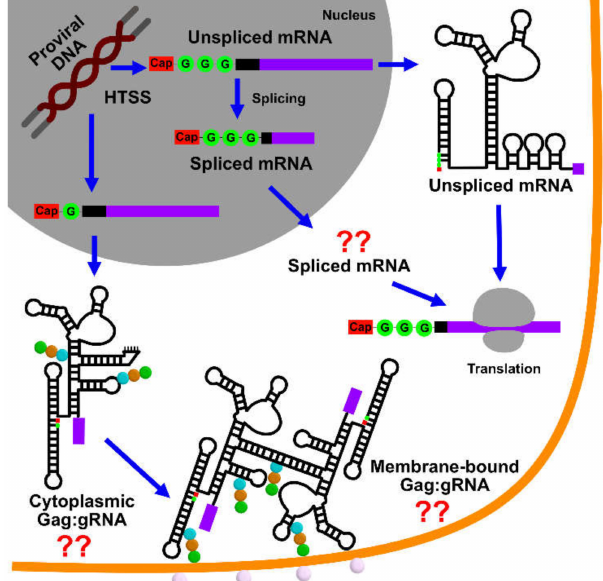
Figure 20. Open questions regarding the structural biology of HIV-1 genome packaging. Structures of spliced mRNAs that avoid packaging are unknown, and structures of gRNA-Gag complexes that anchor the genome to the plasma membrane and nucleate virus assembly are also